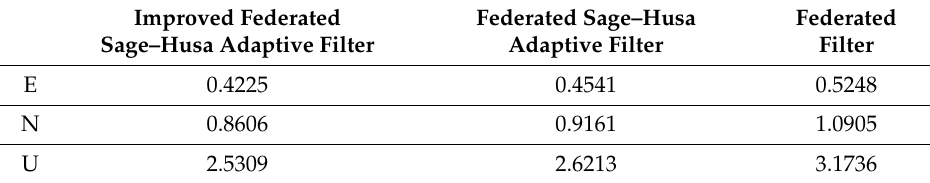
Table 8. Velocity error (m/s).